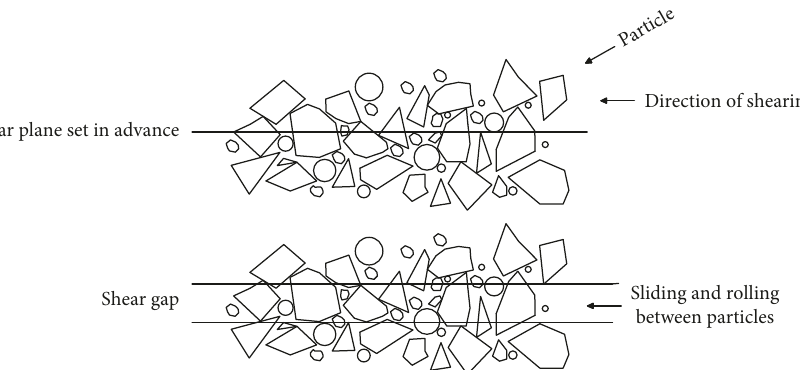
Figure 8: Illustration of the shear gap effect on the particle interaction behavior during shearing.